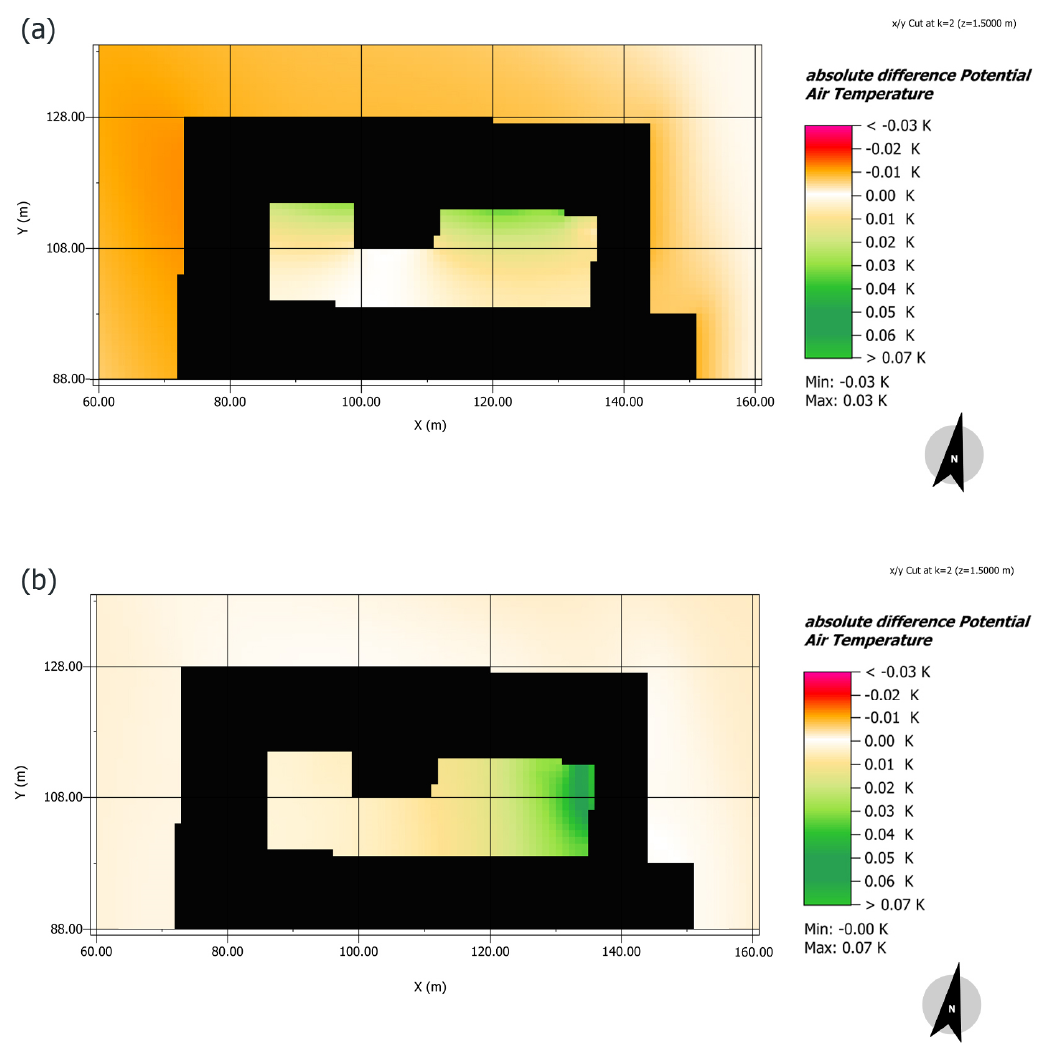
Figure 8. The green wall air temperature scenario with greenery placed on the northern ( a ) and eastern ( b ) wall. Figure by authors.